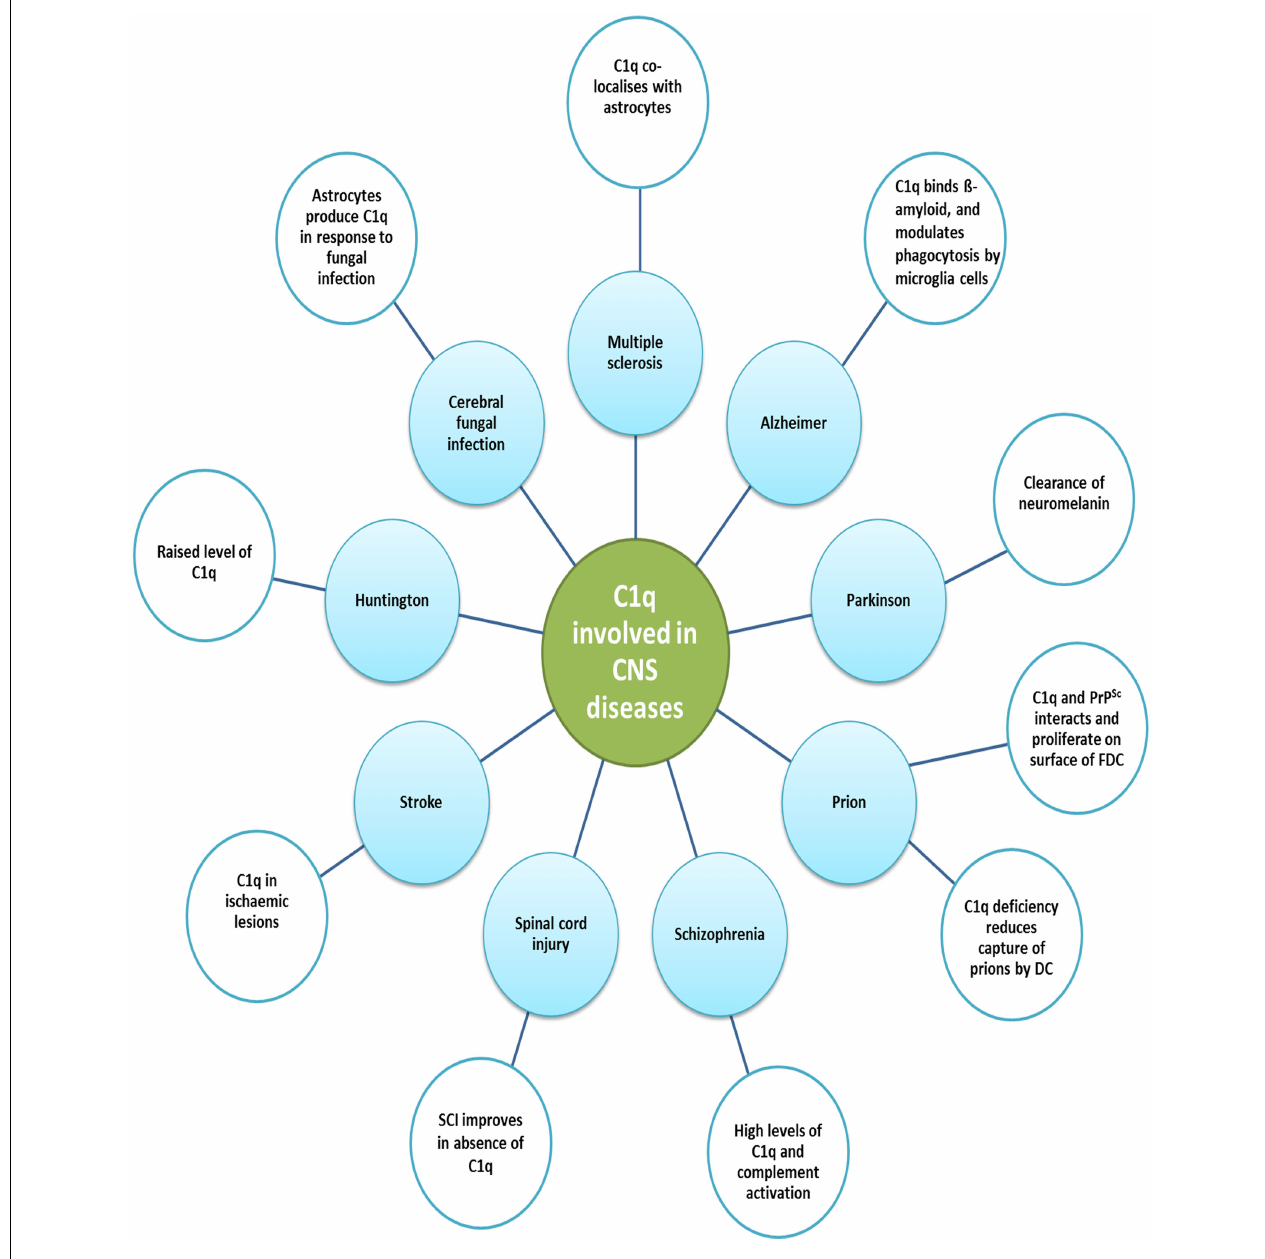
transmitting prions to the CNS. C1q production is triggered in the CNS by astrocytes in response to cerebral fungal infection. The role C1q plays in Parkinson’s disease includes the opsonization of neuromelanin and phagocytosis by microglia cells. Complement pathway up-regulation in brain regions can be observed in AD, which may be due to amyloid β peptides binding within collagen-like domain of C1q, thus activating classical pathway. In addition, fibrillar amyloid β interaction with C1q via activates the classical pathway. Microglia cells, which express C1q in the substantia nigra pars compacta of Parkinson disease, phagocytose and clear debris of degenerating